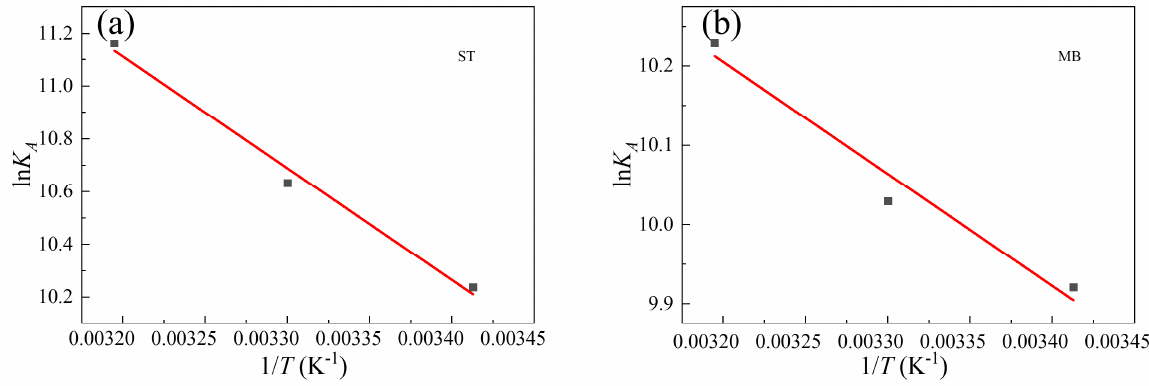
Figure 9. Van’t Hoff plot of ( a ) ST adsorption and ( b ) MB adsorption. Table 5. Thermodynamic parameters for the adsorption of ST and MB over Al 0.3 Zr 0.7 -UiO-66. Adsorbate